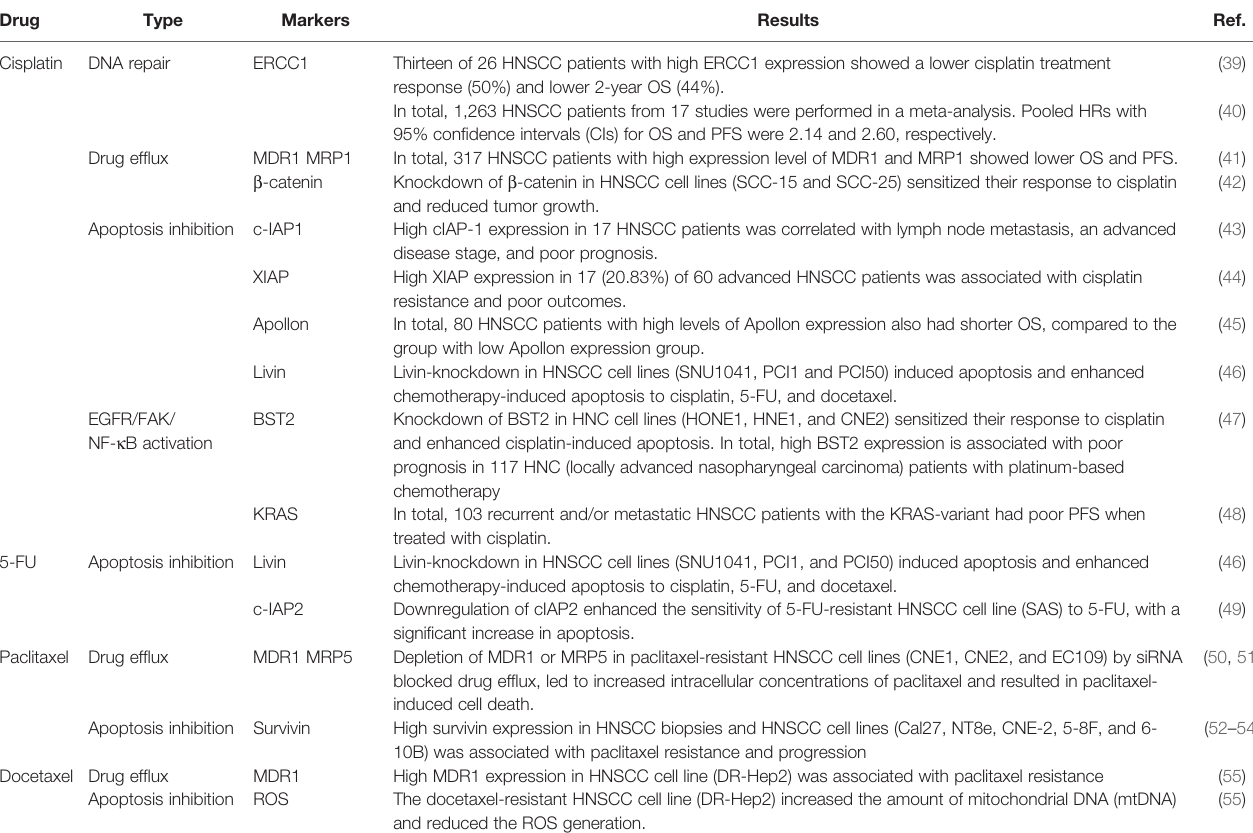
TABLE 1 | Markers of chemotherapy resistance in head and neck cancers (HNCs). Drug Type Markers Results